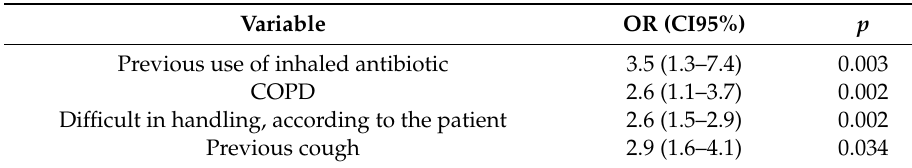
Table 6. Logistical regression. Factors associated with the appearance of cough after the start of dry powder antibiotic